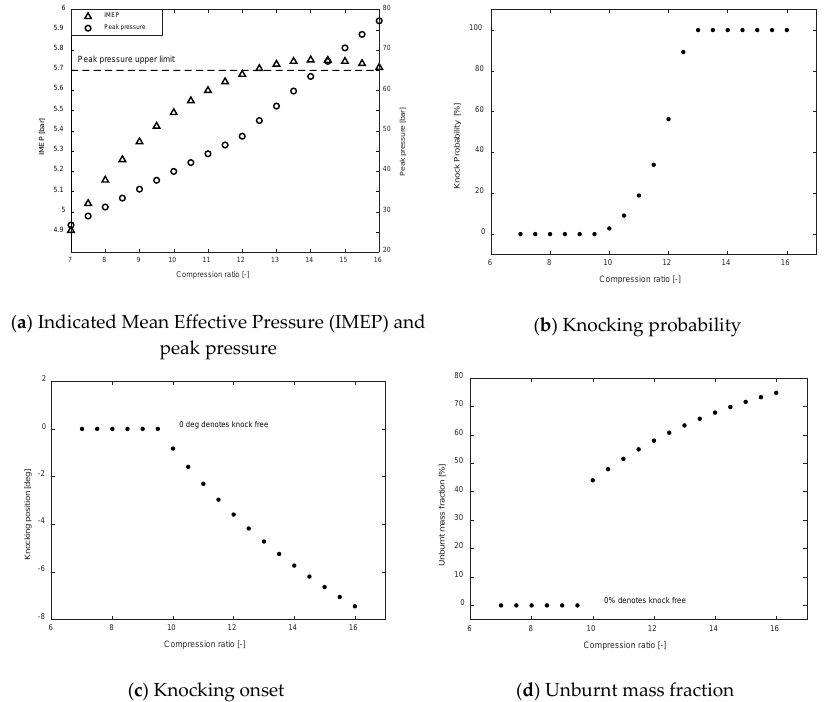
Figure 5. Compression ratio effect on engine and knocking parameters (Engine A).